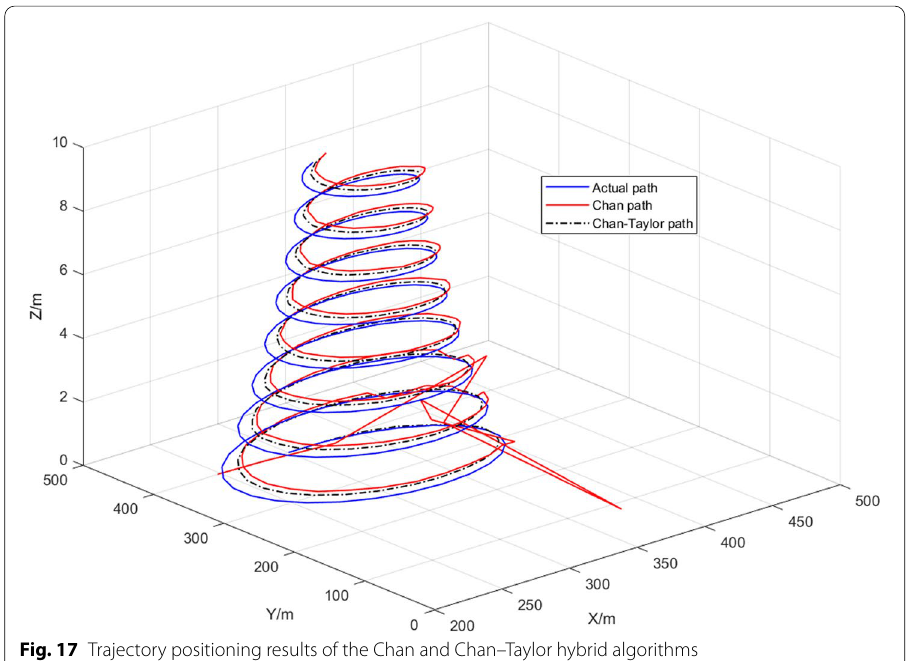
Fig. 17 Trajectory positioning results of the Chan and Chan–Taylor hybrid algorithms